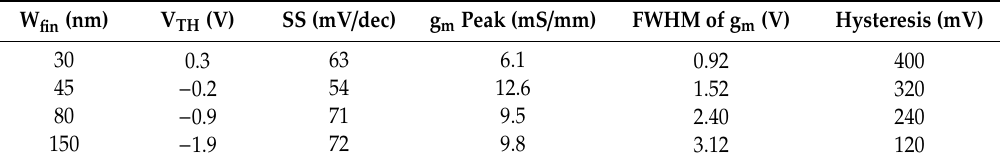
Table 1. Key parameters for each device exhibited in Figure